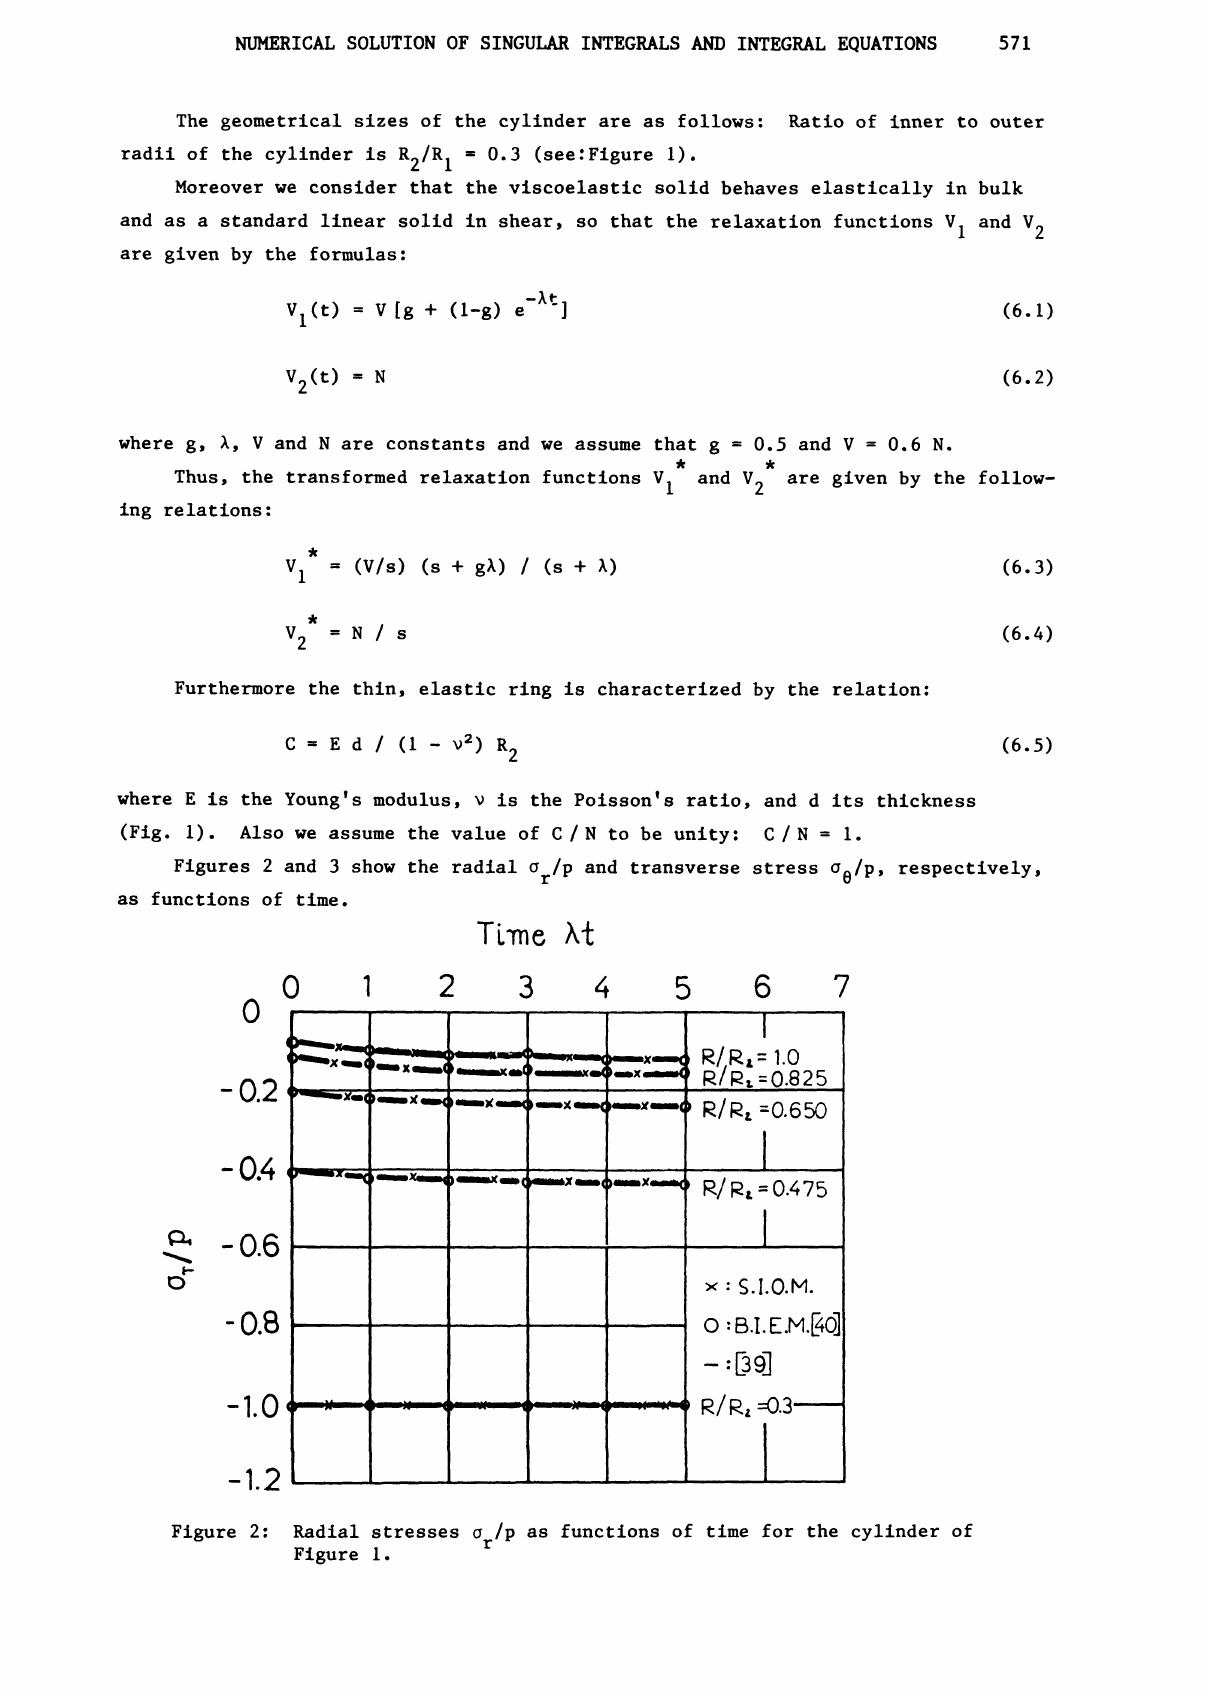
Figure 2: Radial stresses r/p as functions of time for the cylinder of Figure